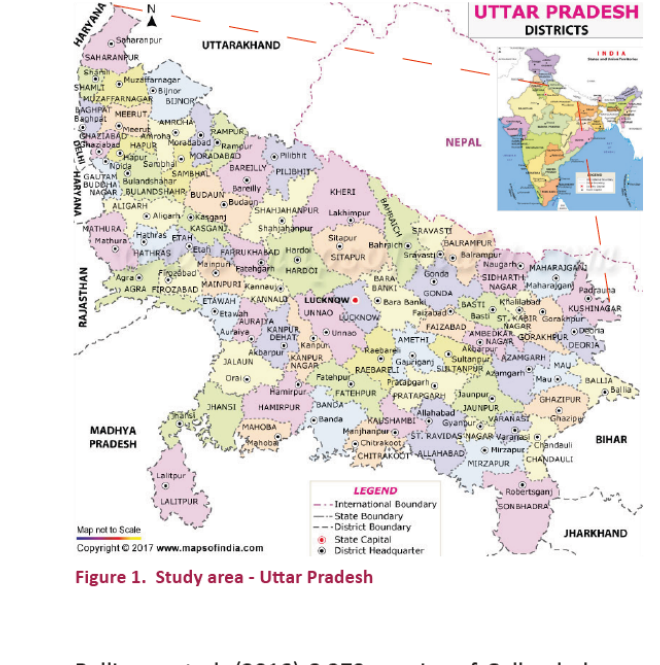
Ffigure 1. Sttudy area - Uttar Pradesh